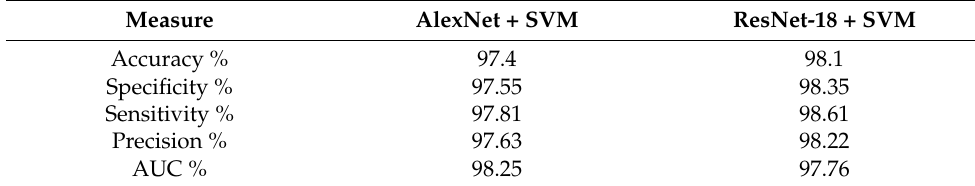
Table 3. Evaluative performance of the hybrid method for early diagnosis of OSCC.